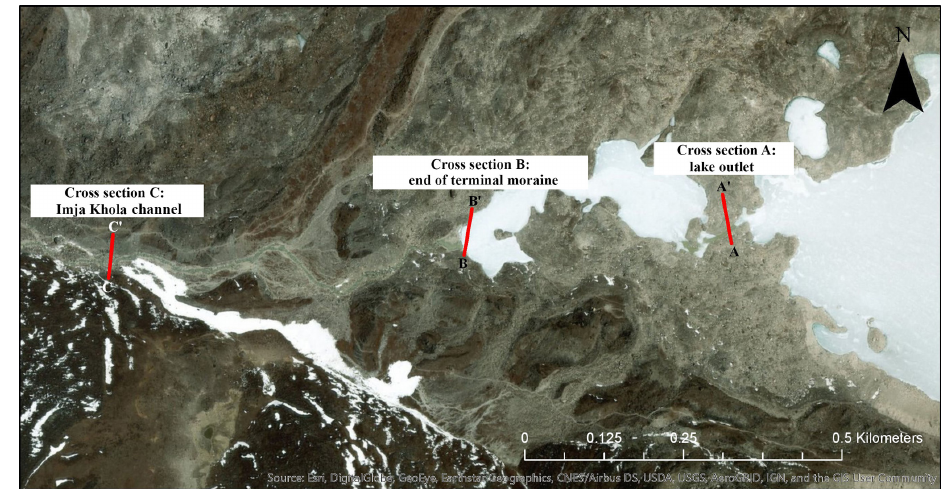
Figure 7. Location of cross sections for discharge and erosion analysis at the start of the terminal moraine (A), end of the moraine (B), and start of the Imja Khola channel